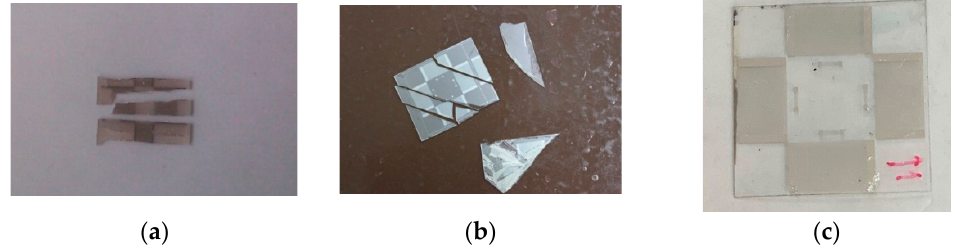
Figure 7. Photos of the samples with ZnO film fabricated at traditional ( a , b ) and modified ( c ) sputtering conditions. ( a ) quartz plate, ZnO film thickness on one face of the plate is 8.2 μ m, ( b ) lithium niobate plate, ZnO thickness on one face of the plate is 5.4 μ m thick, ( c ) lithium niobate plate, ZnO film thickness on both faces of the plate is 5.4 μ m thick.